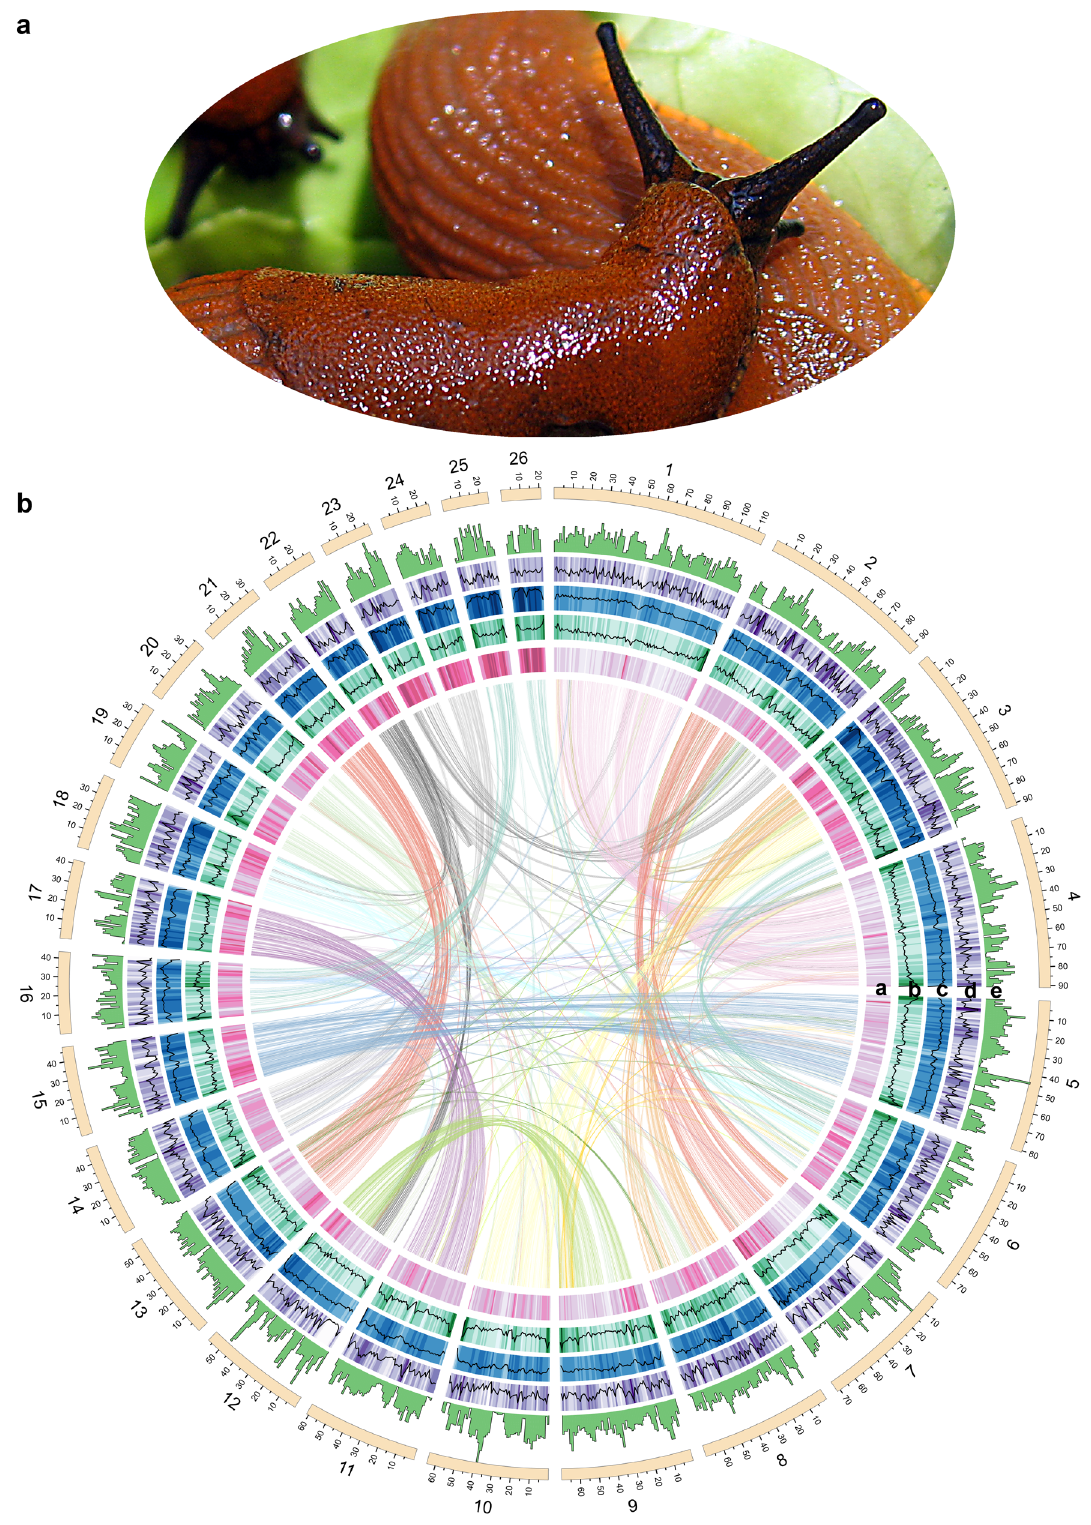
Figure 1. Genome features of Arion vulgaris . ( a ) Adult A. vulgaris . ( b ) General characteristics of the A. vulgaris genome. Tracks from inside to outside correspond to ( a ) GC content, ( b ) LTRs density, ( c ) TEs density, ( d ) genes density, and ( e ) heterozygosity in sliding windows of 1 Mb across each of the 26 pseudochromosomes. Inner lines connect syntenic genes due to ancestral whole-genome duplication